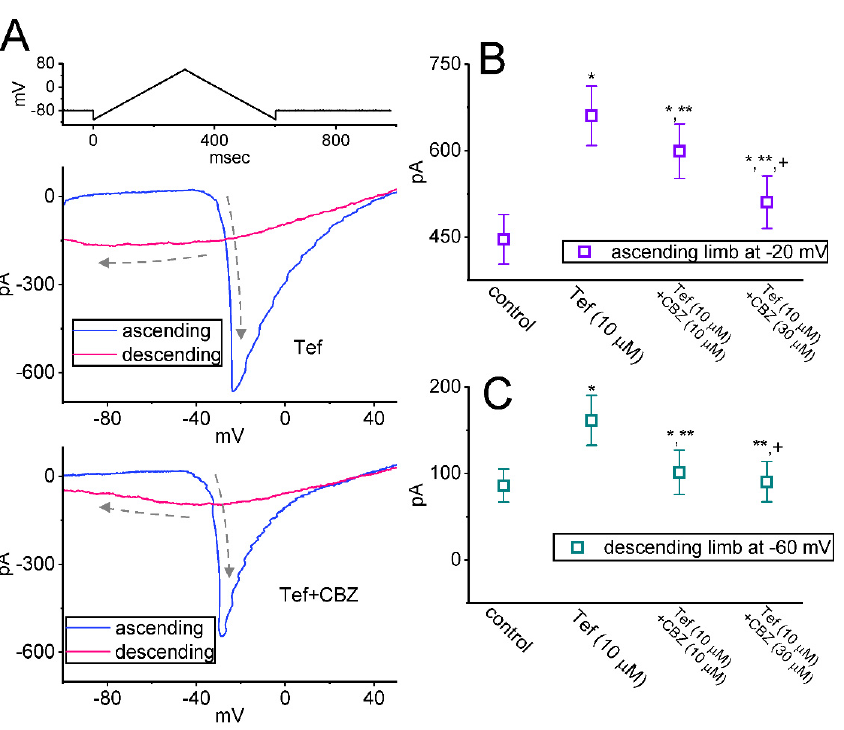
Figure 4. Modification by CBZ and CBZ plus tefluthrin (Tef) on persistent I Na ( I Na(P) ) activated in response to upright isosceles-triangular ramp voltage (V ramp ). This set of recordings was applied to mimic the depolarizing or repolarizing slopes of bursting patterns in excitable cells. ( A ) Representative cur- rent traces were activated by isosceles-triangular V ramp for a duration of 600 ms or with a ramp speed of ±0.5 mV/ms (indicated in the uppermost part). The blue color in the upper or lower part of ( A ) shows the current trace activated by the ascending limb of V ramp acquired in the presence of 10 μ M tefluthrin (Tef) or 10 μ M Tef plus 30 μ M CBZ, respectively, whereas the red color is the trace evoked by the V ramp ’s descending limb. The dashed curves indicate the direction of the current over which time goes during the activation of the triangular V ramp . Notably, there is a voltage-dependent hysteresis (Hys (V) ) (i.e., figure of eight [ ∞ ] configuration) of I Na(P) activated by the isosceles-triangular V ramp during cell exposure to Tef (10 μ M) or Tef (10 μ M) plus CBZ (30 μ M). In ( B , C ), summary graphs, respectively, demonstrate the inhibitory effect of Tef (10 μ M) and Tef (10 μ M) plus CBZ (10 or 30 μ M) on the am- plitude of I Na(P) activated by the upsloping (at − 20 mV) and downsloping (at − 60 mV) limbs of the tri- angular V ramp (mean ± SEM; n = 8 for each point). The horizontal bars in ( B , C ) indicate the mean values. The analysis was made by one-way ANOVA (F value = 4.9; p < 0.05). * Significantly different from controls ( p < 0.05), ** significantly different from Tef (10 μ M) alone group (t value = 3.6; p < 0.05), and + significantly different from Tef (10 μ M) plus CBZ (10 μ M) group (t value = 3.5; p < 0.05). 2.5. Effect of CBZ on the Recovery from I Na(T) Inactivation Evoked during Varying Interpulse Intervals Next, a two-step voltage protocol in which the interpulse interval increases with a geometrics-based progression (common ratio = 2) was applied to the tested cell to see whether CBZ leads to any adjustments on the recovery of I Na(T) from inactivation. In this protocol, a 30 ms step from − 80 to − 10 mV (prepulse, the first pulse) was first applied and followed by another 30 ms step to − 10 mV (test pulse, the second pulse) to inactivate most of the current during various interpulse interval (i.e., interval between the first and second pulse). The recovery from current inactivation was then examined at different time points with a geometrics-based progression at the holding potential of − 80 mV, as presented semi-logarithmically in Figure 5. The time constants of recovery from I Na(T) inactivation acquired in the absence and presence of 10 μ M CBZ were least-squares fitted by a single- exponential with the values of 75.3 ± 2.3 and 223.1 ± 6.2 ms (n = 8; p < 0.05), respectively. The experimental observations thus indicate that there was a measurable prolongation in the recovery from I Na(T) inactivation as Neuro-2a cells were exposed to CBZ.